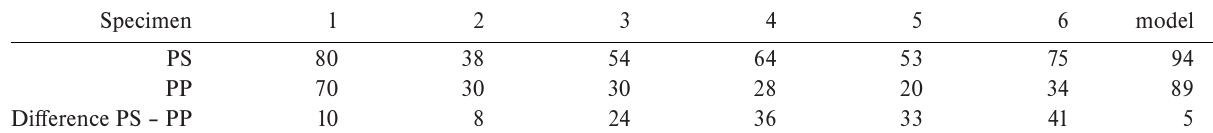
Table 5. Maximum force values [N] for loading option c.